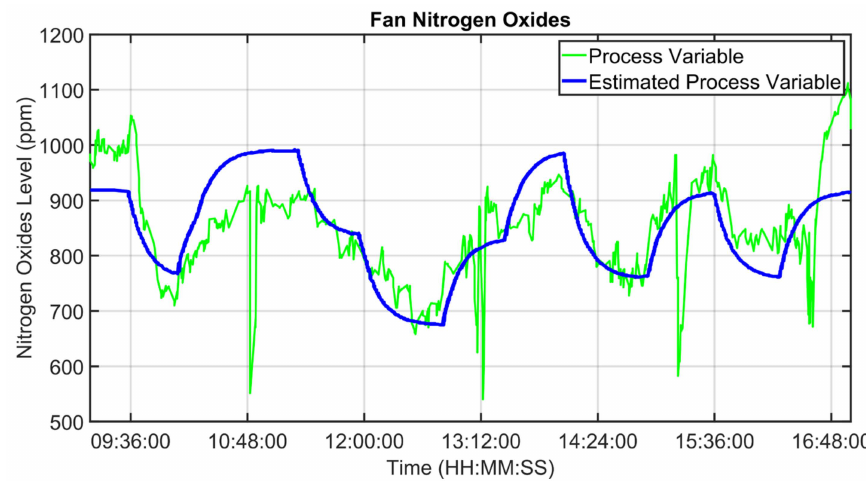
Figure 14. Rotary kiln APC system: modelization results (fan nitrogen oxides).